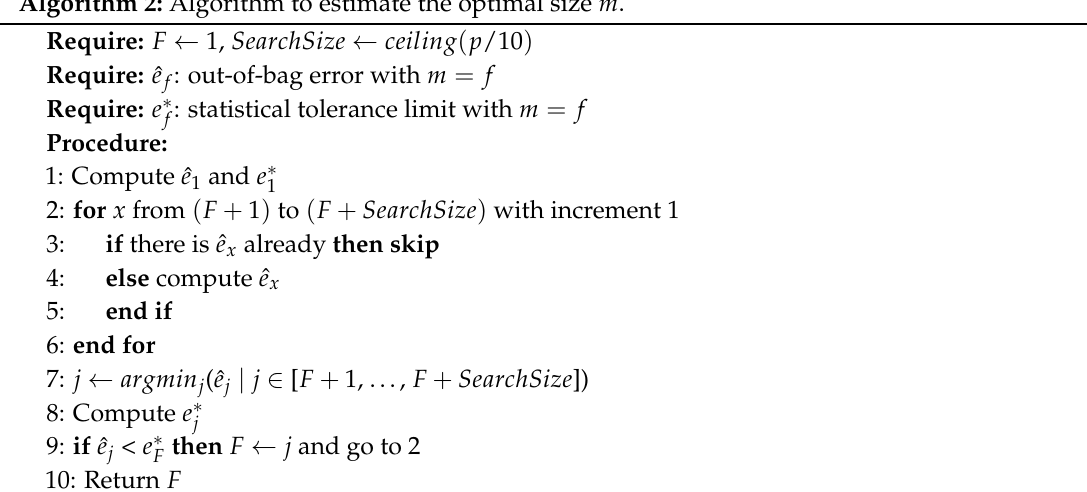
Algorithm 2: Algorithm to estimate the optimal size m